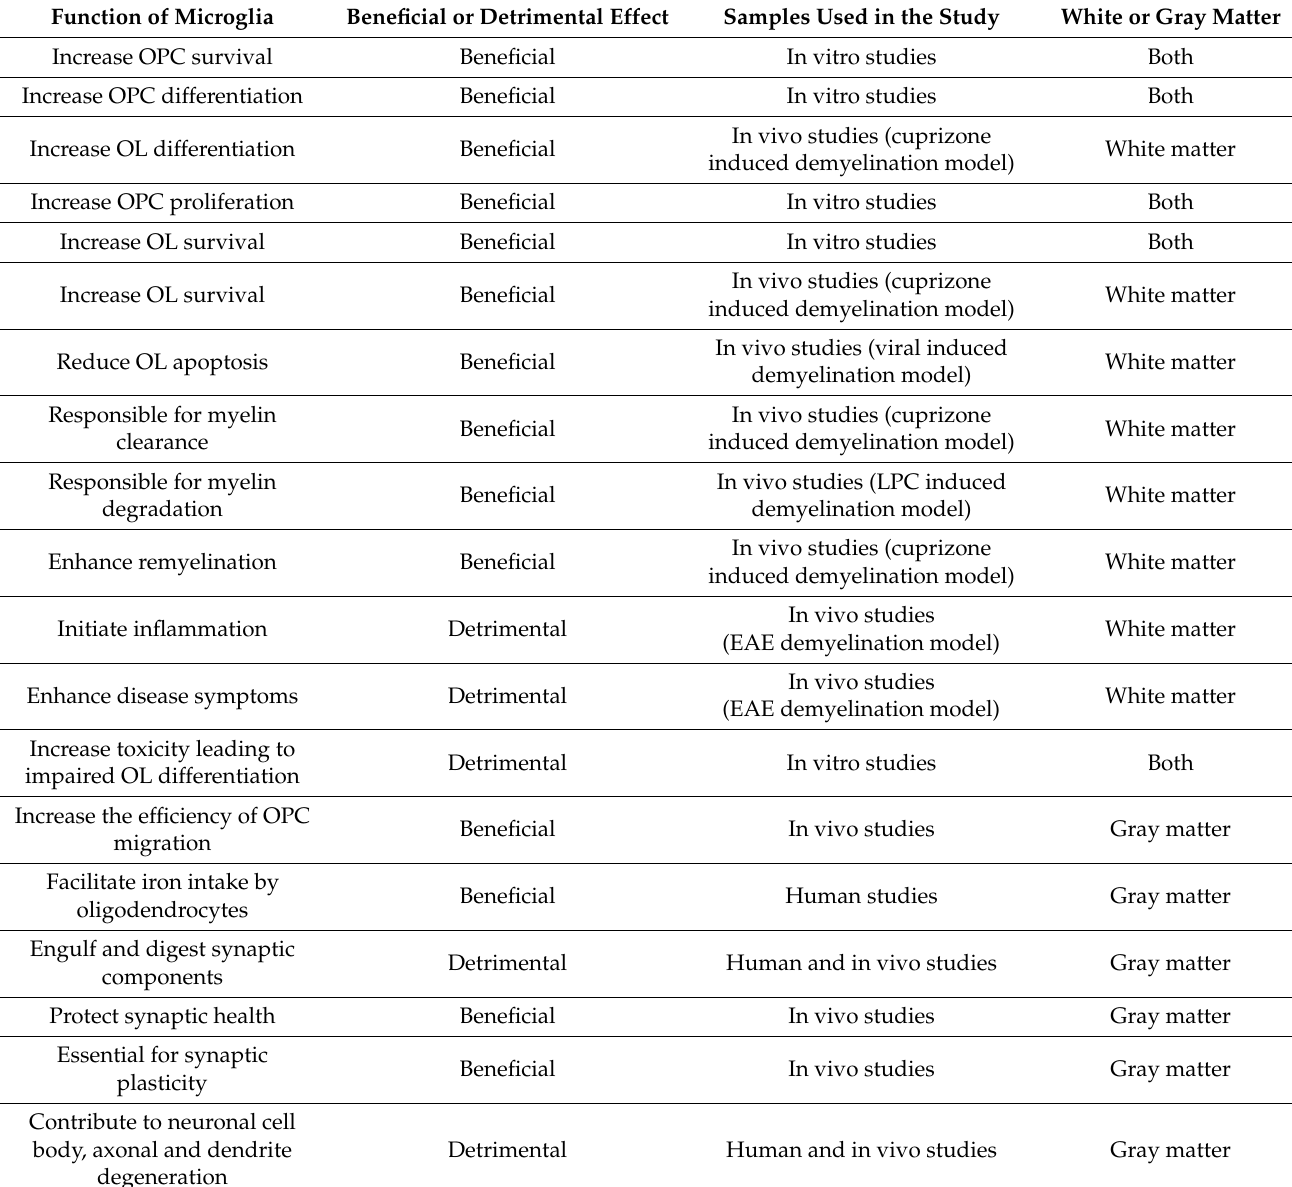
Table 1. Summary table summarizing the functions of microglia during myelin damage and repair and indicating their beneficial or detrimental roles, as well as their